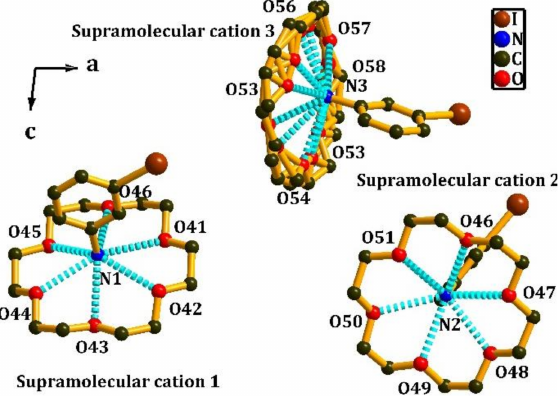
Figure 5. The structure of supramolecular cations in Crystal 2 . Hydrogen atoms are omitted for clarity, and dotted cyan represents hydrogen bonds.